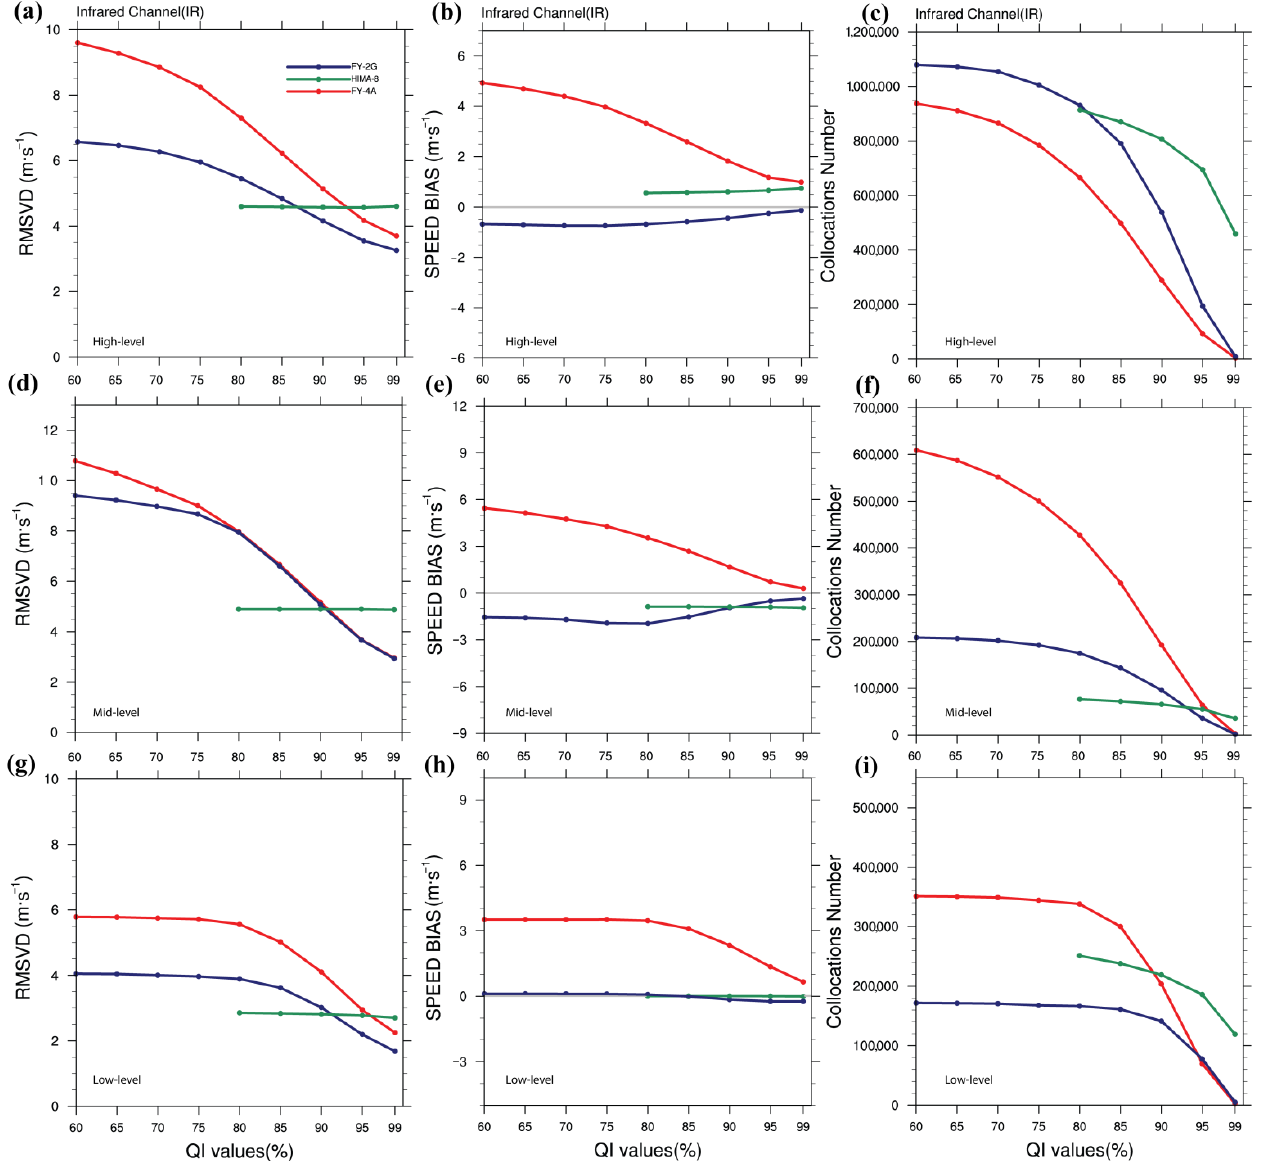
Figure 5. The mean RMSVD ( a , d , g ), BIAS ( b , e , h ), and numbers of collocations ( c , f , i ) of IR AMVs for different levels from high, mid, and low-levels using variable QI values from 60 to 100% in December 2018.